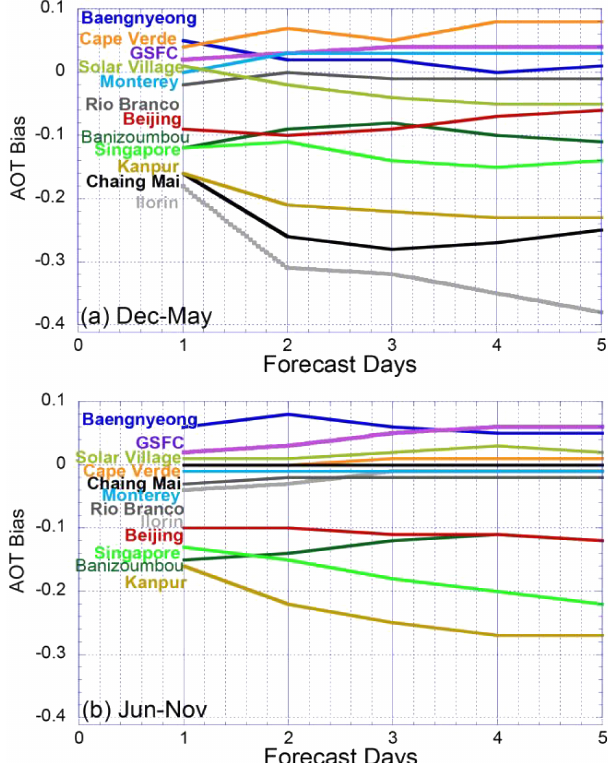
Figure 6. ICAP-MME 550nm total AOT model bias as a function of forecast hour for key AERONET sites. (a) December–May boreal winter–spring period; (b) June–November boreal summer–fall.